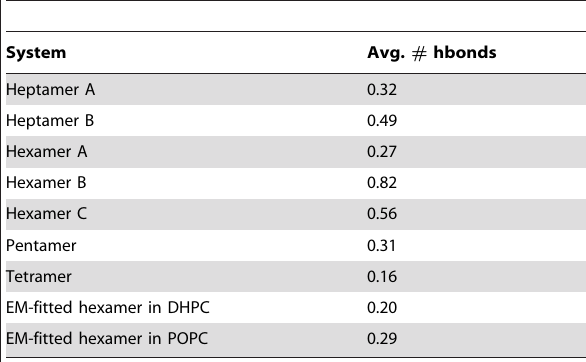
Table 1. Average number of inter-subunit hydrogen bonds, per